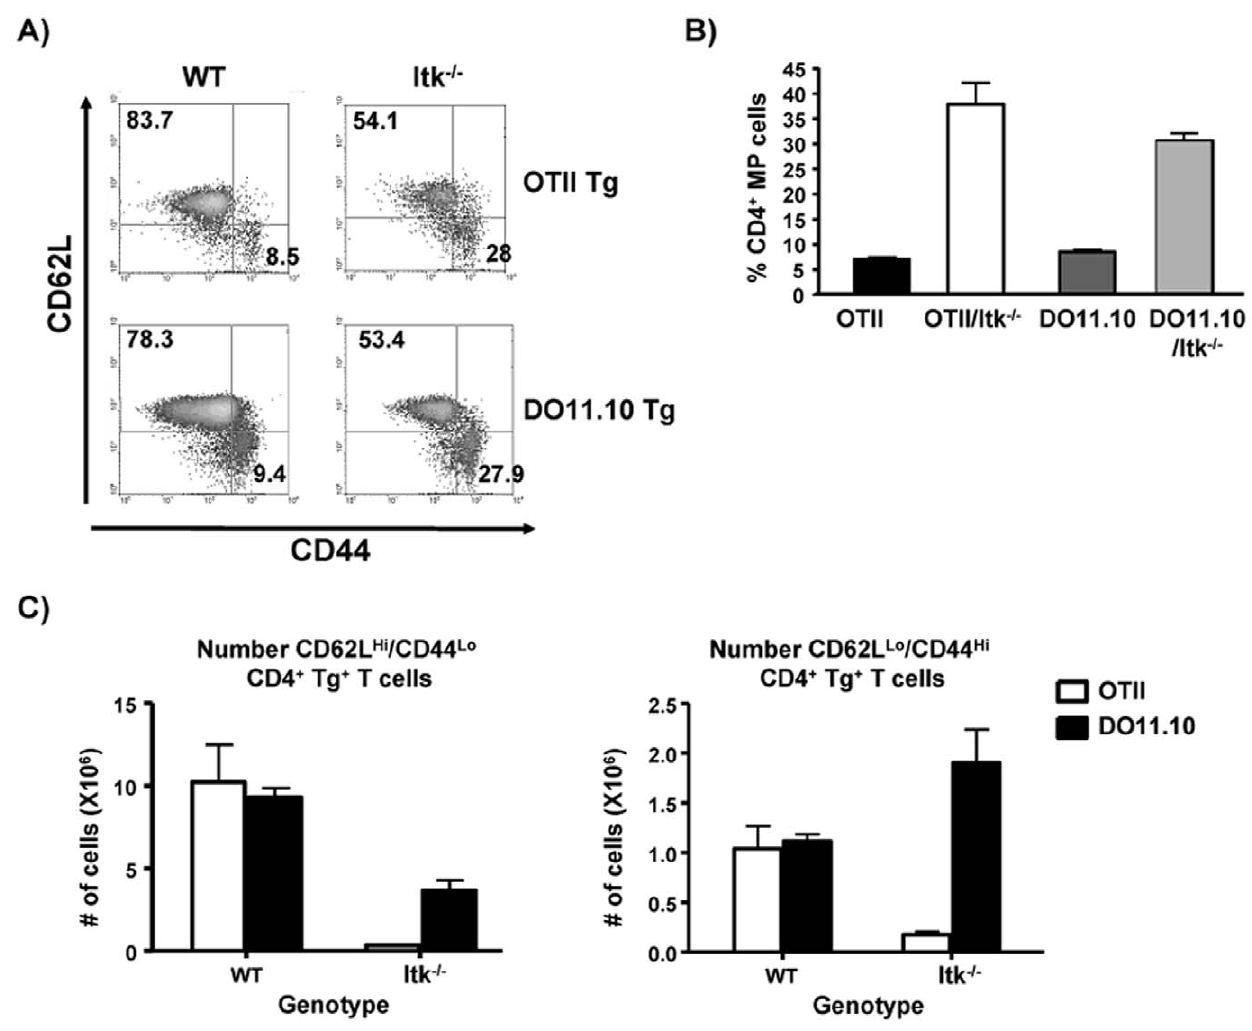
Figure 7. Reduced development of naı¨ve TCR transgene positive CD4 + T cells in OT-II/Itk 2 / 2 and DO11.10/Itk 2 / 2 mice. ( A ) CD4 + / transgene TCR + splenocytes from OT-II, OT-II/Itk 2 / 2 , DO11.10 and DO11.10/Itk 2 / 2 mice were analyzed for CD44 and CD62L. ( B ) The percentages of TCR transgene, CD4, CD44 hi and CD62L lo T cells for each genotype is indicated. p , 0.05, n=3–5. ( C ) The number of TCR transgene, CD4 + CD62L lo CD44 hi as well as CD4 + CD62L hi CD44 lo T cells for each genotype is indicated.